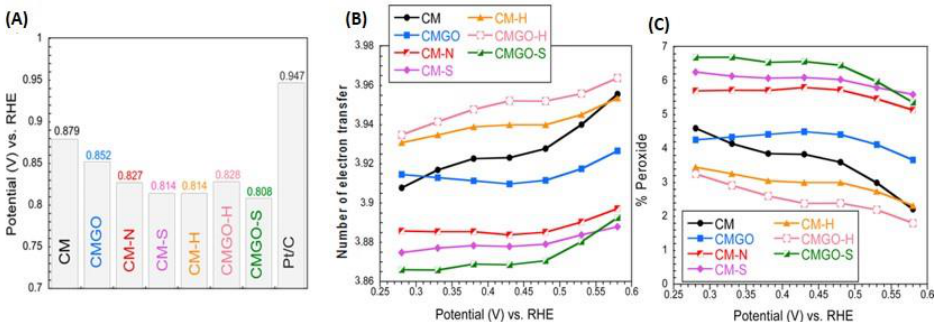
Figure 9. Comparison of the ( A ) onset potential, ( B ) the number of electron transfer, and ( C ) the percentage of oxygen reduced to peroxide. Reprinted with permission from Reference [54]. Copyright 2017, American Chemical Society.